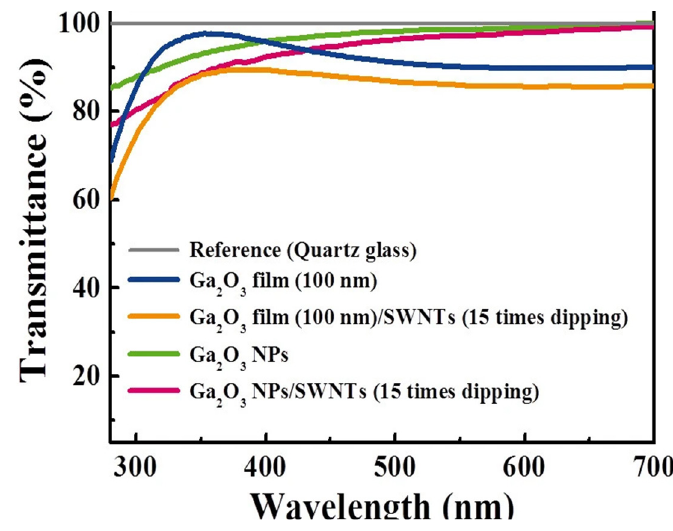
Figure 7. Optical transmittance spectra of undoped Ga 2 O 3 film [41].